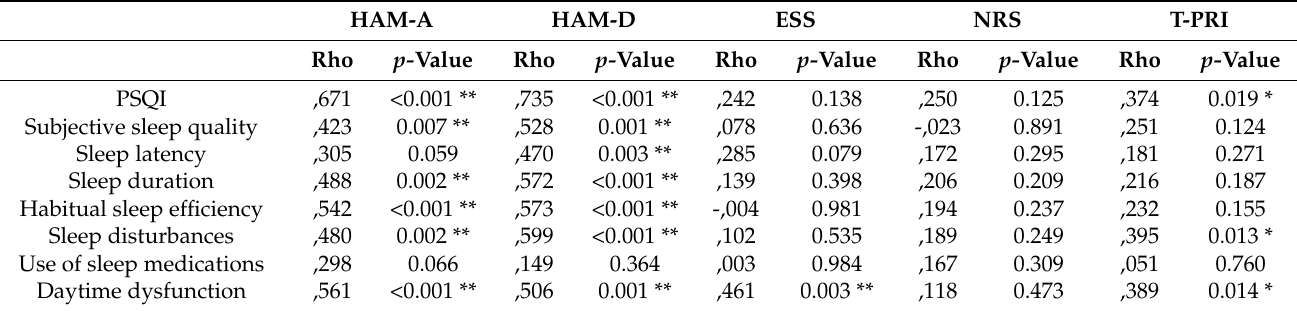
Table 5. Correlation analysis between the PSQI items and anxiety, depression and pain in 50 OSCC patients and 50